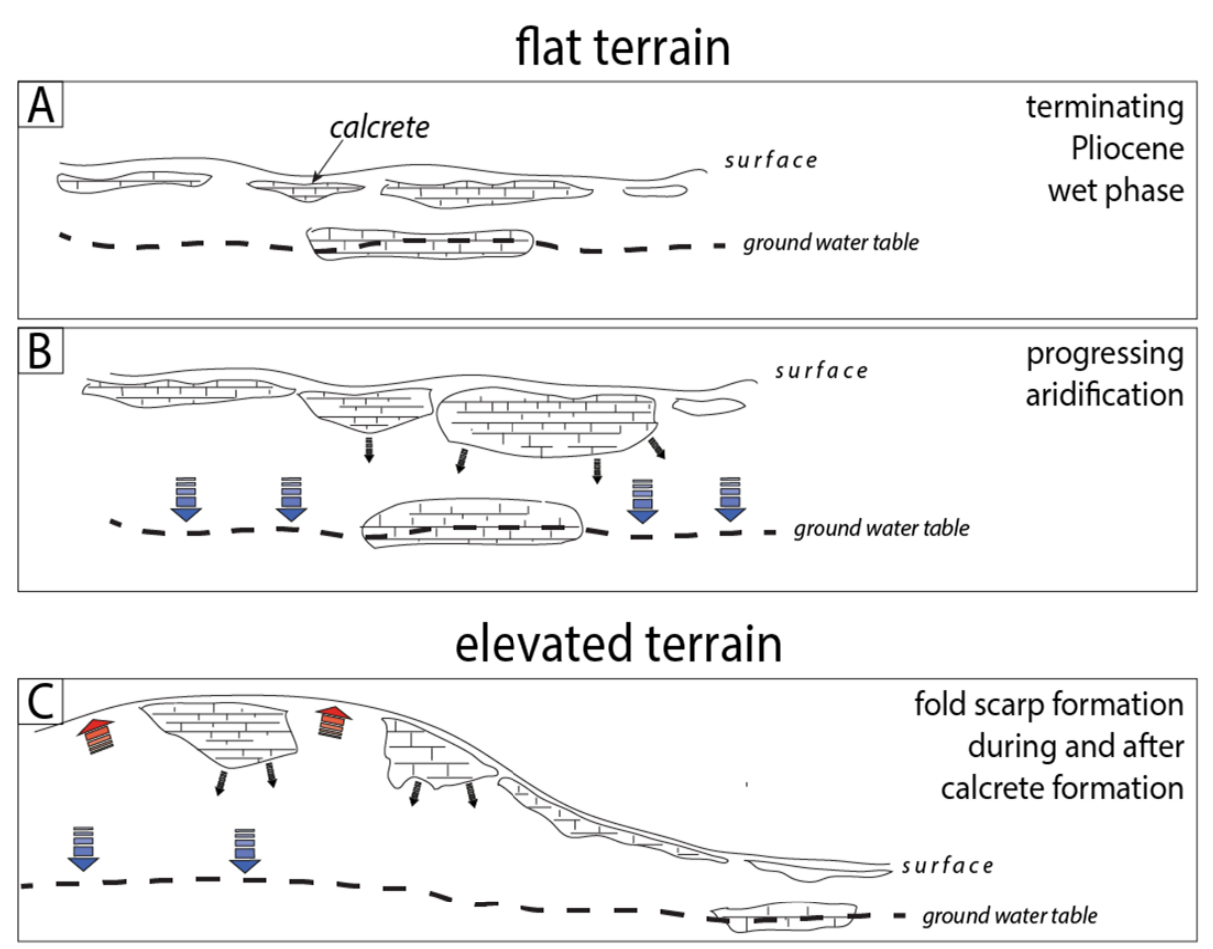
Figure 17. Schematic interpretation of calcrete formation under climate and topographic variability.